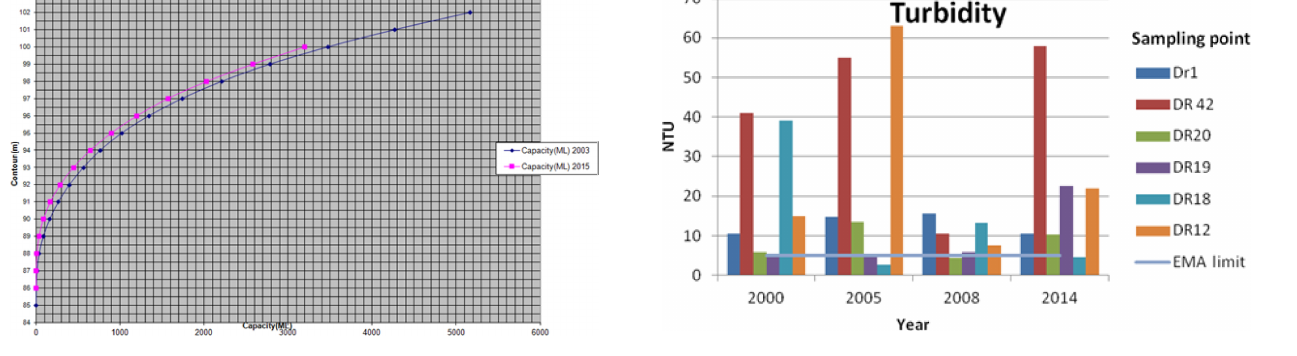
Figure 5. Chimhanda Dam Capacity comparison over the years. Figure 6. Turbidity variation among sampling points.